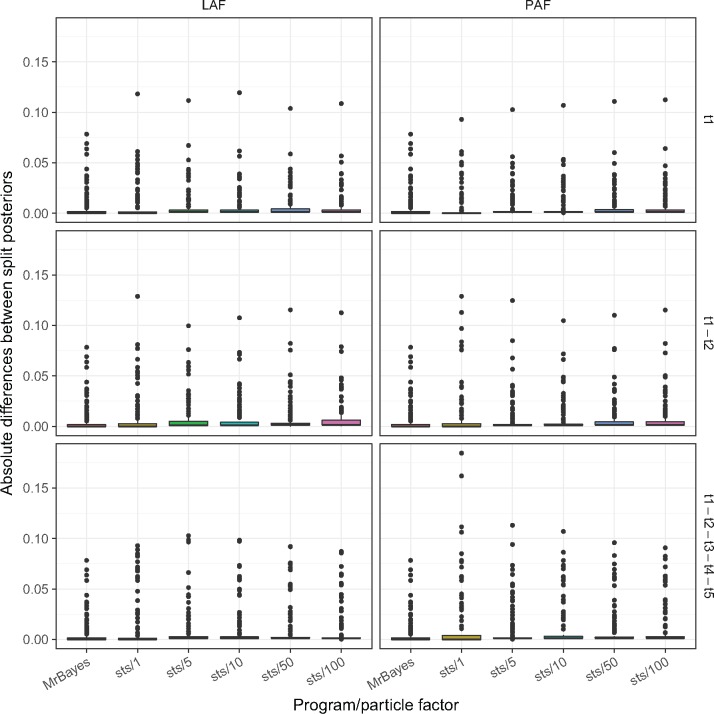
Absolute value of the difference between the split frequencies of \documentclass[12pt]{minimal}
\usepackage{amsmath}
\usepackage{wasysym}
\usepackage{amsfonts}
\usepackage{amssymb}
\usepackage{amsbsy}
\usepackage{upgreek}
\usepackage{mathrsfs}
\setlength{\oddsidemargin}{-69pt}
\begin{document}
}{}$\textsf{sts}$\end{document} and MrBayes. These results are for data set D1T100. Labels on the right of the y-axis indicate which taxa were removed.